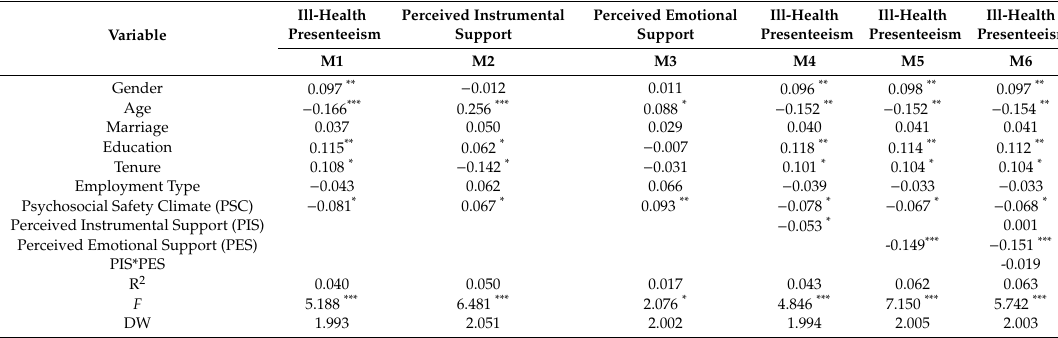
Table 3. Test results of the direct and mediating e ff